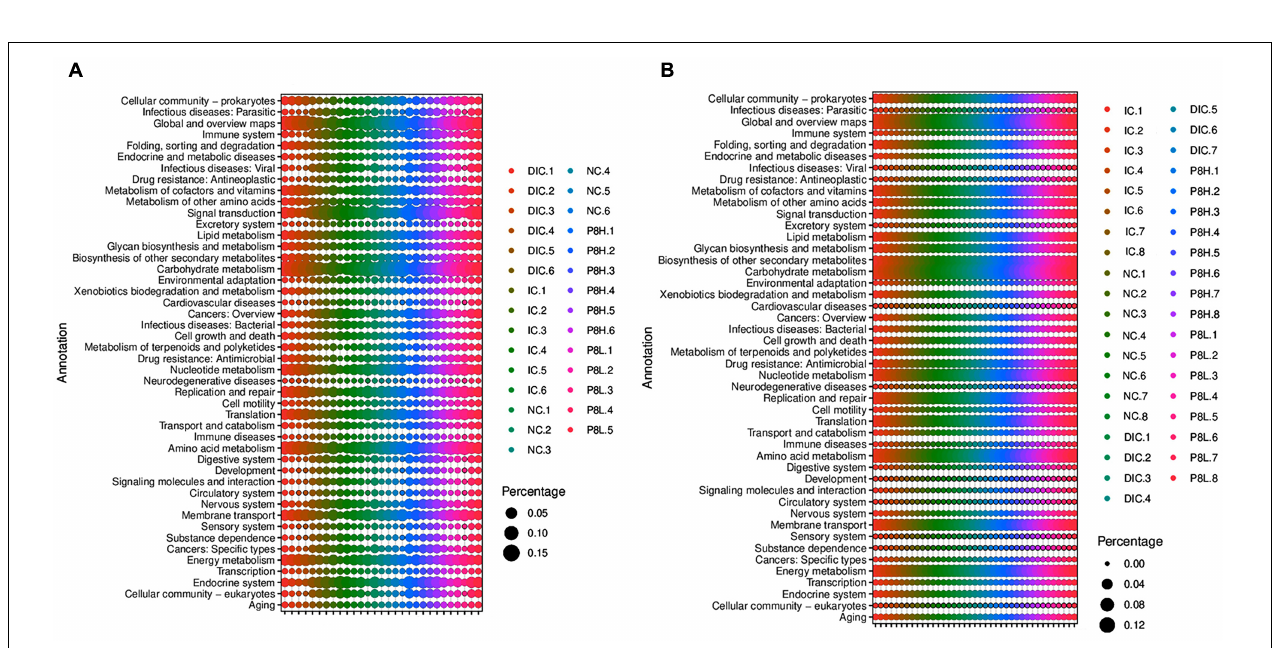
FIGURE 6 | The Spearman correlation analyses of gut microbiota, coccidia with biochemical parameters of Eimeria -infected broilers. (A) Day 21, (B) day 42.